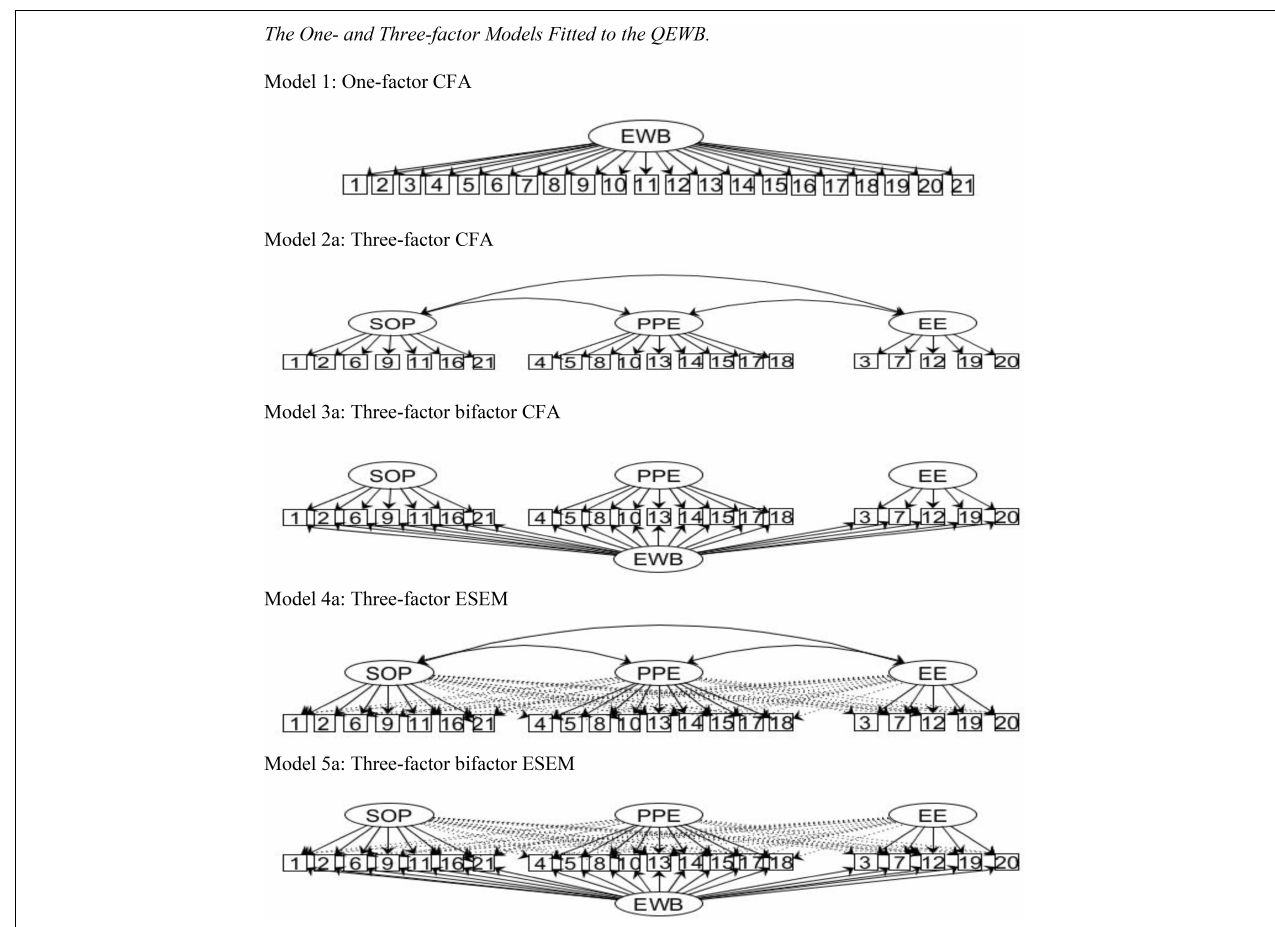
FIGURE 1 | The one- and three-factor models fitted to the QEWB. Model 1: One-factor CFA. Model 2a: Three-factor CFA. Model 3a: Three-factor bifactor CFA. Model 4a: Three-factor ESEM. Model 5a: Three-factor bifactor ESEM. EWB, Eudaimonic Well-being; SOP, Sense of Purpose factor; PPE, Purposeful Personal Expressiveness factor; EE, Effortful Engagement